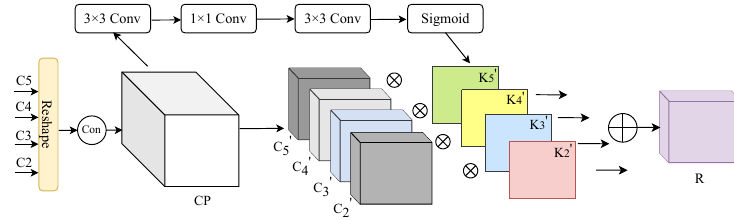
Figure 4. The proposed fine-grained feature aggregation (FiFA)